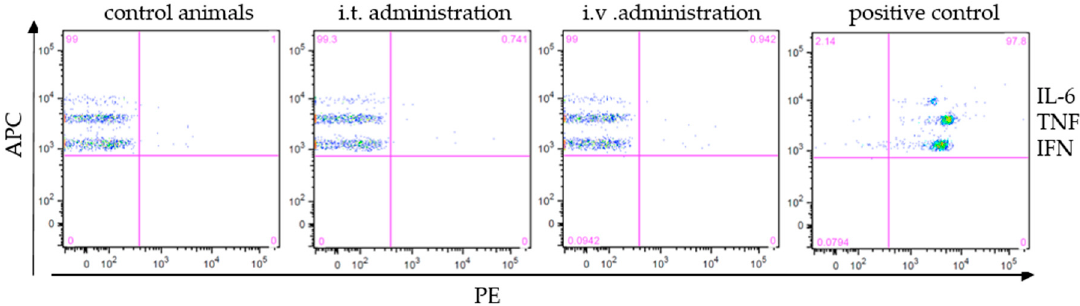
Figure A4. Levels of secreted cytokines (IL—6, IFN— γ , and TNF— α ) in peripheral blood of control animals, animals who received NDA135b intratumorally, and animals who received NDA135b intravenously. Positive control stands for mixture of 625 pg / mL of each of the three cytokines (test standards). Representative images are